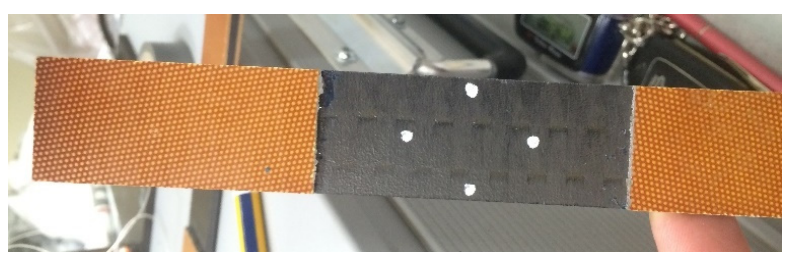
Figure 1. CFRP sample before quasistatic uniaxial tensile testing.